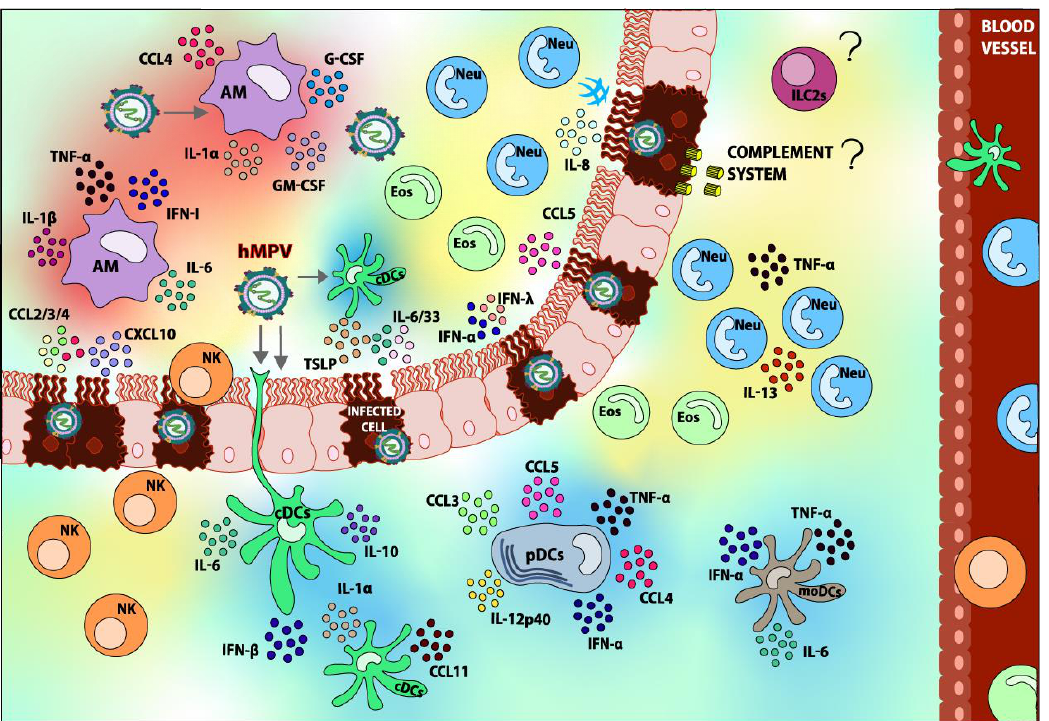
Figure 2. Innate immune response elicited upon hMPV infection. After the detection of hMPV, various types of immune cells are recruited to the lung. Within the innate immune cells, Dendritic cells (DCs), Alveolar Macrophages (AMs), Neutrophils (Neu), Eosinophils (Eos), and Natural Killer cells (NK) can be found. Most of these cells play a role in the pathology of the infection. However, Group 2 Innate Lymphoid Cells 2 (ILC2s) and the role of the Complement System during the infection have not been reported yet, and this lack of information is illustrated with “?” in the figure. The role of the respiratory epithelium in the recruitment of innate immune cells can also be appreciated. Components shaded in blue are elements that contribute to hMPV disease resolving, whereas components shaded in red are considered detrimental and contribute to hMPV pathogenesis overall. Elements shaded in yellow are those whose contributions to hMPV pathology are not well studied or are controversial. The arrows indicate the possible targets of infection.